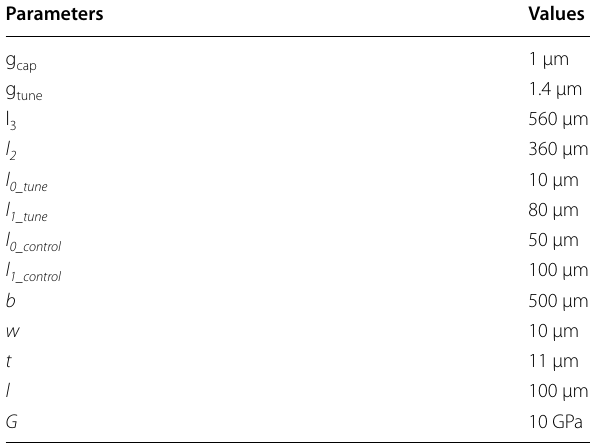
Parameters Values